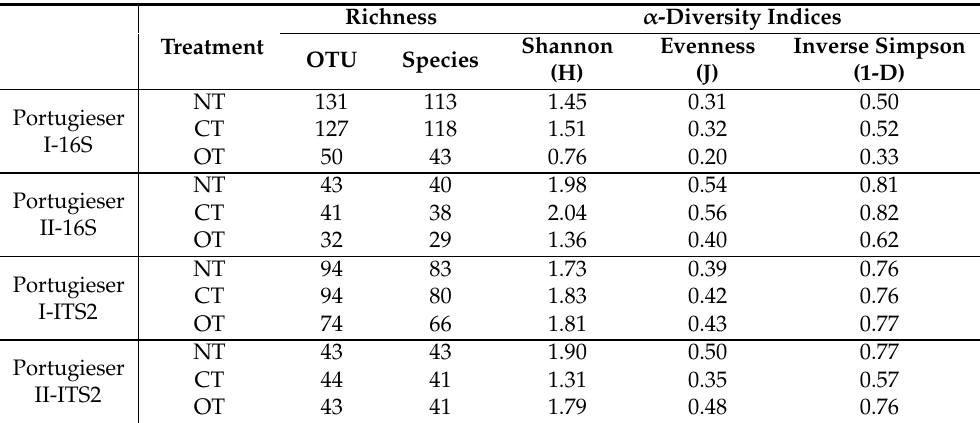
Table 1. Species richness, α -diversity indices obtained from 16S and ITS sequencing of carpoplane microbiota. Samples derived from Portugieser berries 1 day (Portugieser I) or 2 weeks (Portugieser II) after the last agrochemical treatment. Non-treated (NT), conventionally treated (CT) and ozonide- treated (OT) samples were